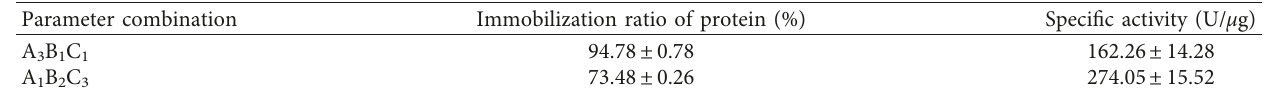
Table 4: Results of confirmatory